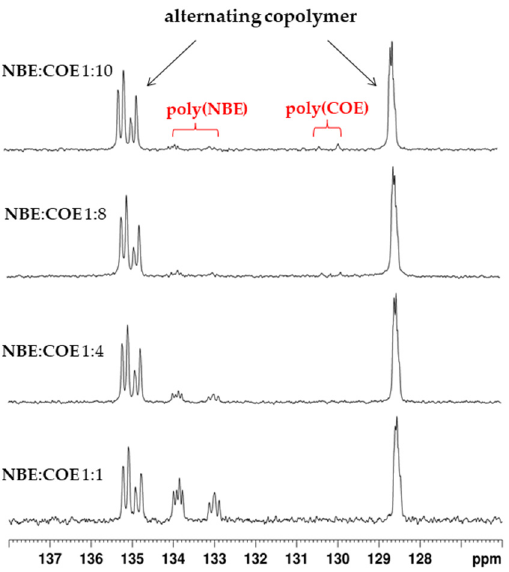
Figure 4. Olefinic region of 13 C NMR (150 MHz) spectra of alternating NBE-COE obtained via catalyst 4 .